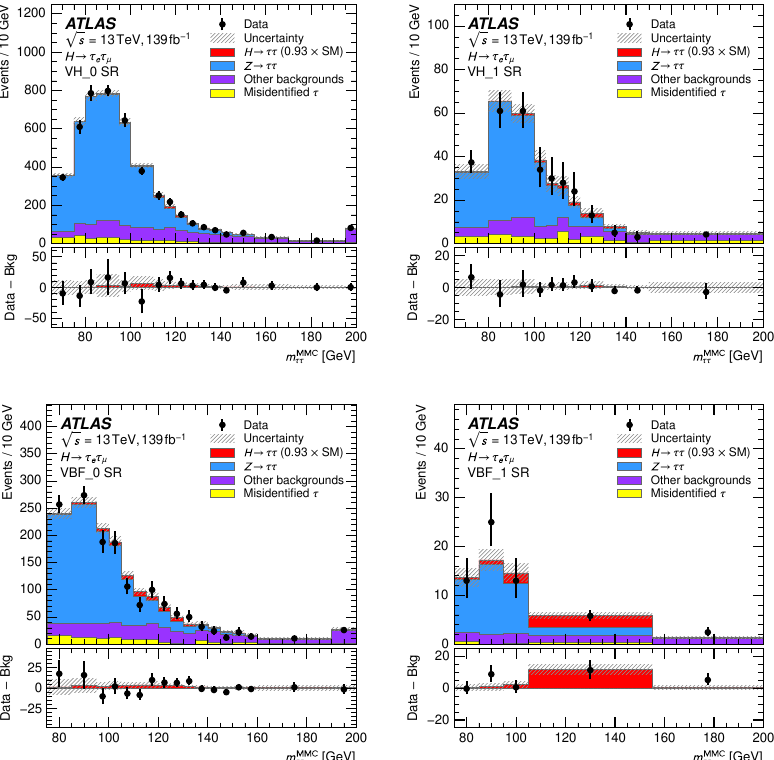
Figure 15. Distribution of the reconstructed ττ invariant mass ( m MMC ) for all events in the ττ V(had)H and VBF categories of the τ τ channel. The bottom panel shows the differences between e µ the numbers of observed data events and expected background events (black points). The observed Higgs boson signal, corresponding to ( σ × B ) / ( σ × B ) = 0 . 93 , is shown with a filled red histogram. SM Entries with values above the x -axis range are shown in the last bin of each distributions. The dashed band indicates the total uncertainty on the total predicted yields. The prediction for each sample is determined from the likelihood fit performed to measure the pp → H → ττ